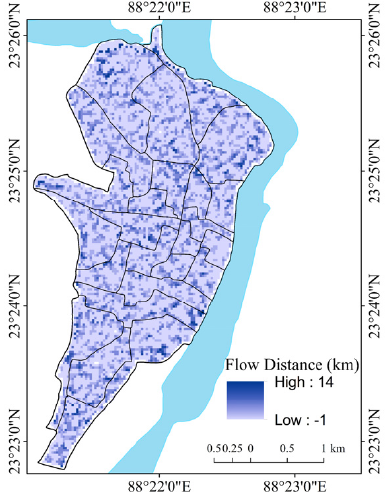
Figure 17. Flow distance (2000).